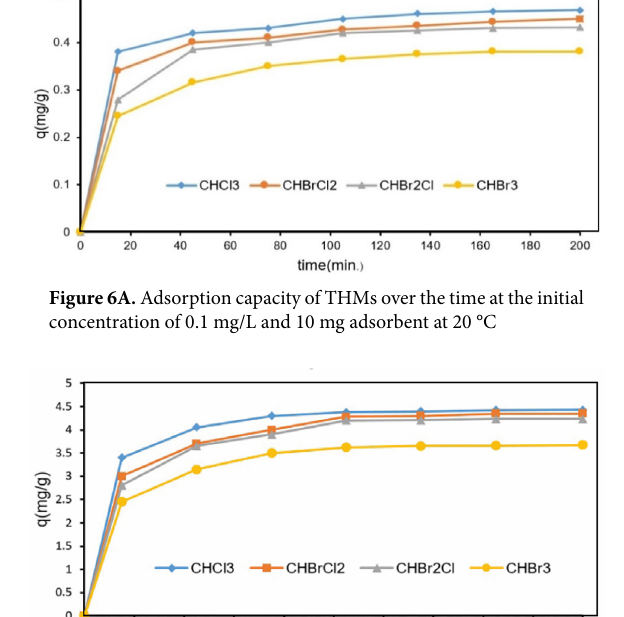
Table 4. The equilibrium time was 165 min for C 0 =